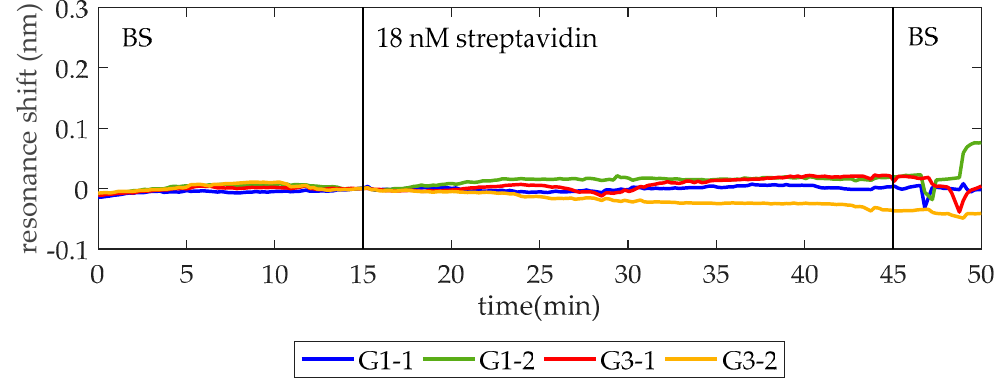
Figure 3. To test the recognition specificity, 18 nM streptavidin in blocking solution (BS) is flowed over the thrombin binding aptamer (TBA) functionalized photonic chip. In minute 15, after establishing a baseline with BS, the streptavidin solution is injected. One minute later (the time required for the solutions to reach the sensor form the syringe pump), it entered into the fluidic chamber and no change related to detection is observed, confirming that the surface is totally blocked and no unspecific recognition occurred.